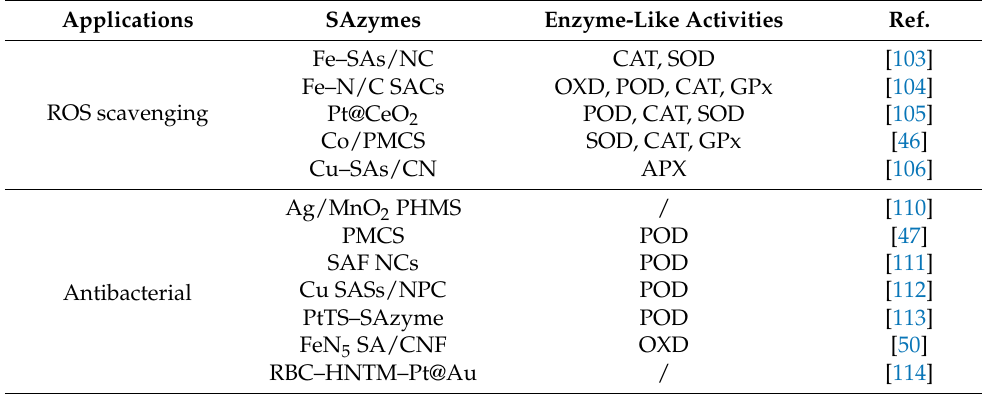
Table 3. Summary of applications of SAzymes in ROS scavenging and